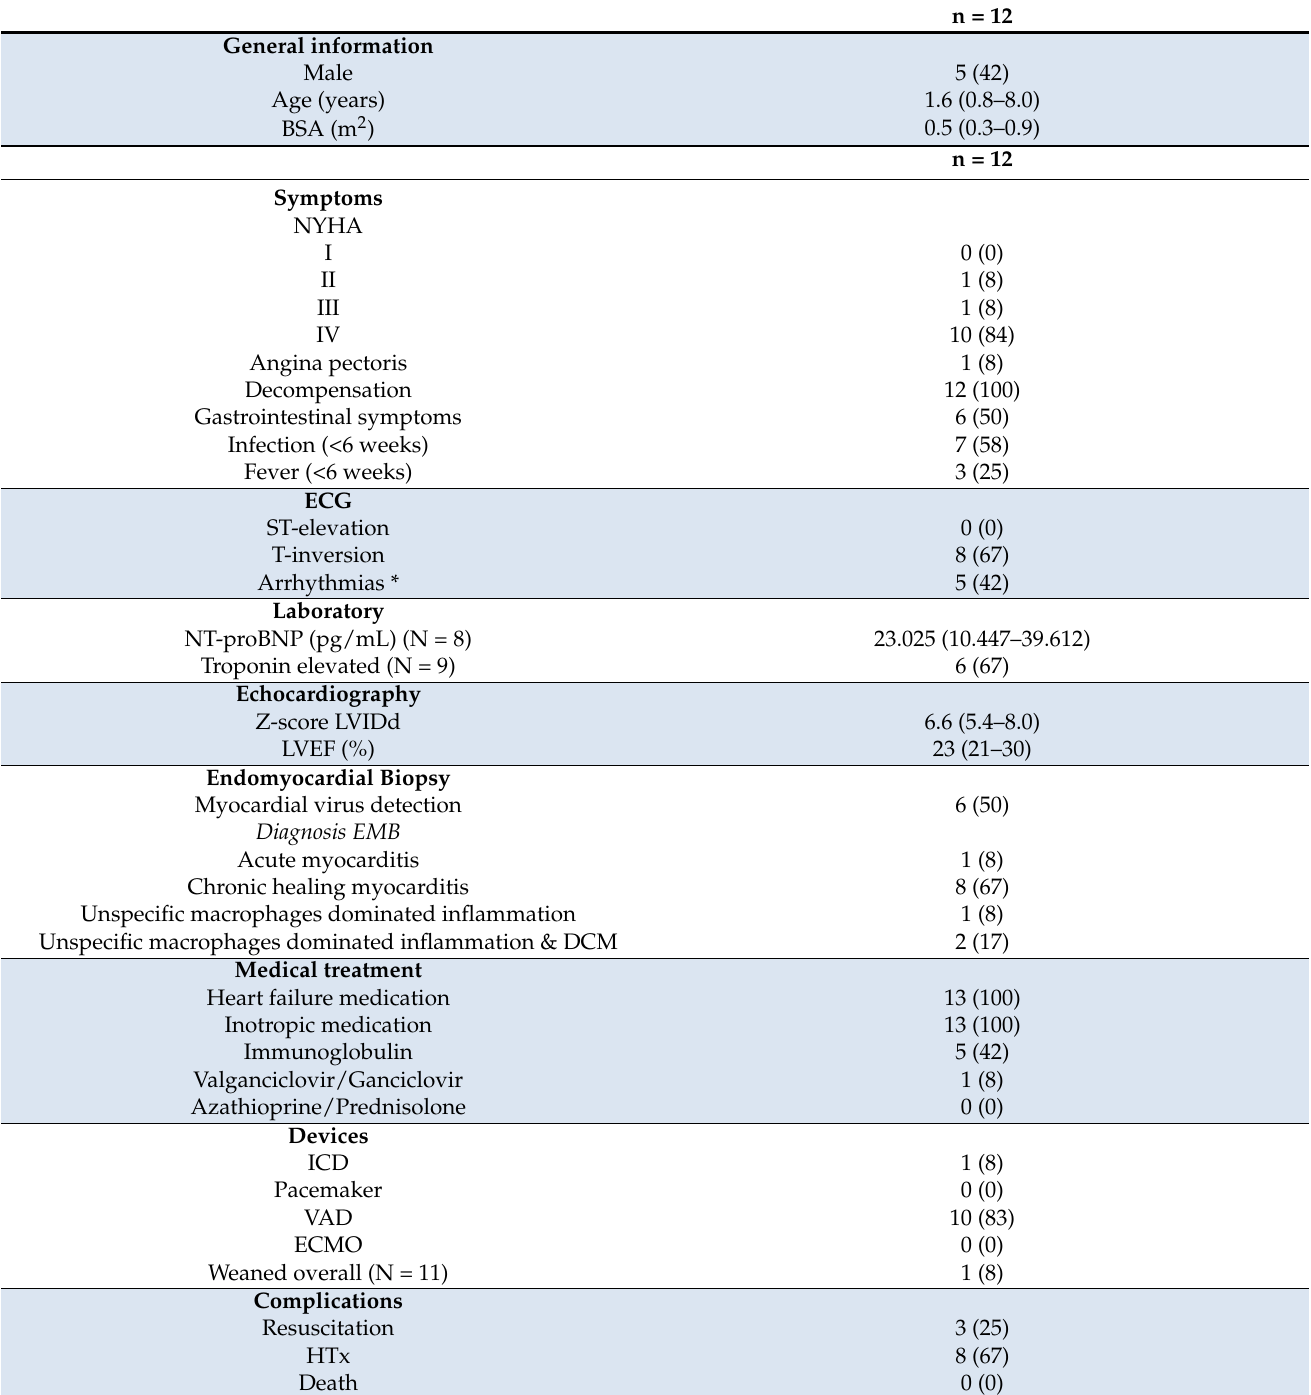
Table 1. Patient